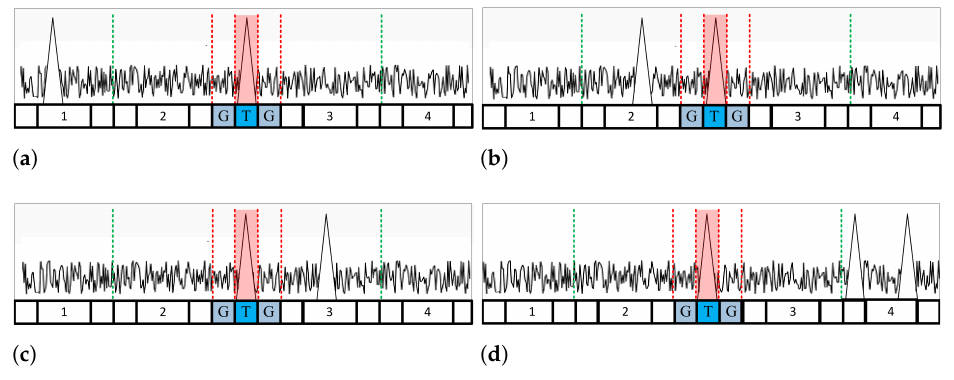
Figure 3. A case where a window is determined as a multitarget environment: interfering target is